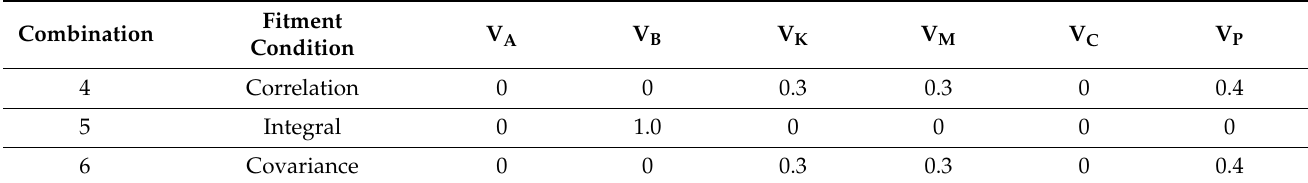
Table 4. Optimized dye solutions from anode-adsorbed UV-Vis data (reference Figure 7, quadrants III and